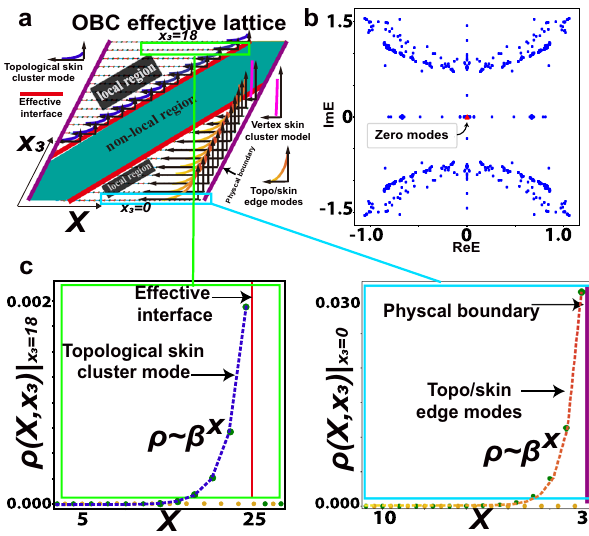
Fig. 2 Localizations in the effective lattic for the Hamiltonian in Eq.(1) under OBCs. Localizations in the effective lattice for the 3-boson sector under open boundary conditions (OBCs). a Schematic of the effective Hilbert space lattice for the 3-boson sector under OBCs. Regions with local (white) and non-local (cyan) effective hoppings are demarcated by the interaction-induced effective interfaces (red lines). Topological skin cluster modes accumulate against effective interfaces, while vertex skin clusters are localized at intersections between effective interfaces and physical edges (purple), which also host ordinary skin/topo edge modes. b The three-boson OBC spectrum with parameters t 1 = 1.0, t 2 = 0.2, γ = 0.8, on a (2 L − 5) × L effective lattice ( L = 20). Zero modes correspond to either topological edge modes or skin clusters. c Spatial density pro fi les ρ ð X ; x 3 Þ ¼ (cid:4) (cid:4) (cid:4) (cid:4) 2 of both types of topological modes, which clearly accumulate at Ψ ð X ; x Þ 3 either the effective interface or physical boundary with identical decay pro fi les ρ ( X , x 3 ) ~ β X , β = ( t 1 + γ )/( γ − t 2 ) (see methods). Green and yellow dots in c correspond to the horizontal even and odd sites in a . More details of the exponential localizations can be found in in Supplementary Note Fig. 2. When we consider PBCs, where the physical boundary is no longer present, we obtain more types of states without conventional OBC analogs. Instead of “ topological skin clusters ” , we now have “ interface skin clusters ” , “ extended skin clusters ” and “ localized skin clusters ” , which are represented by gray, blue, and red modes in Fig. 3. As suggested by their name, “ interface skin clusters ” are highly localized at the effective boundaries, while the other two types, “ localized skin clusters ” and “ extended skin clusters ” , appear in the coupled and noncoupled chains in the effective lattice. Among these fi ve states, only the “ localized skin clusters ” and “ extended skin clusters ” have direct generalized in the higher dimensional Hilbert space of N > 3-boson clusters ( N > 3-boson sector). We will further elaborate on these states in Fig. 5 below and surrounding paragraphs, as well as in Supplementary Note 1.